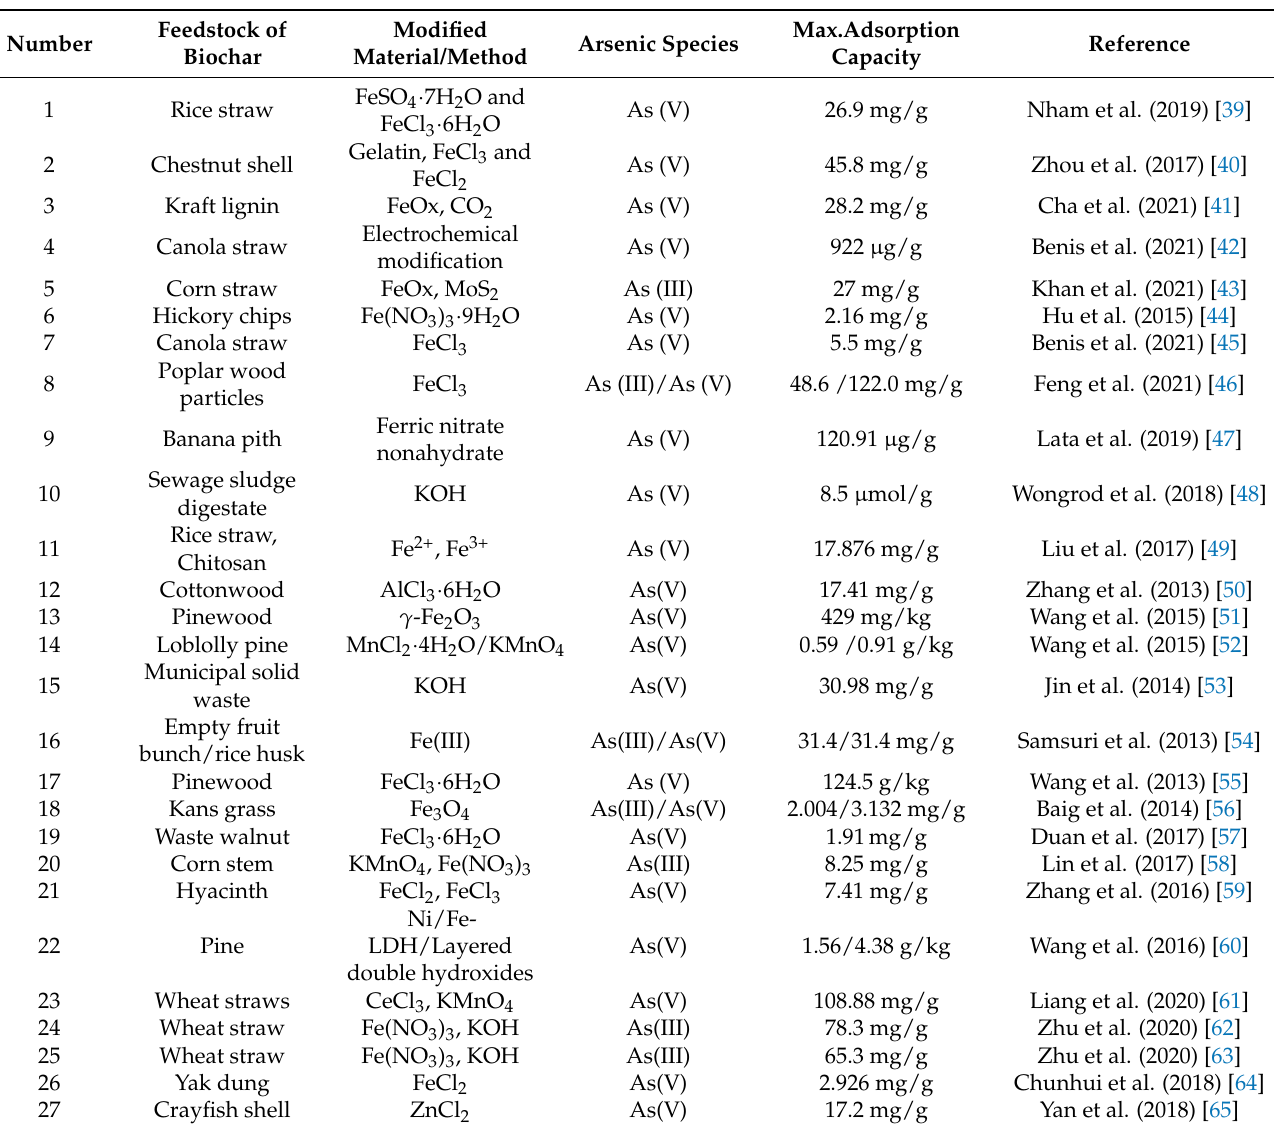
Table 1. The reviews on arsenic in the last